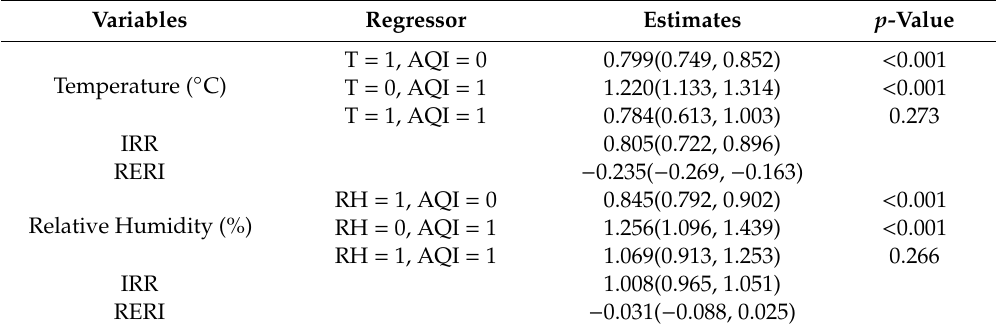
Table 4. Interactive analysis between AQI and climatic factors on respiratory